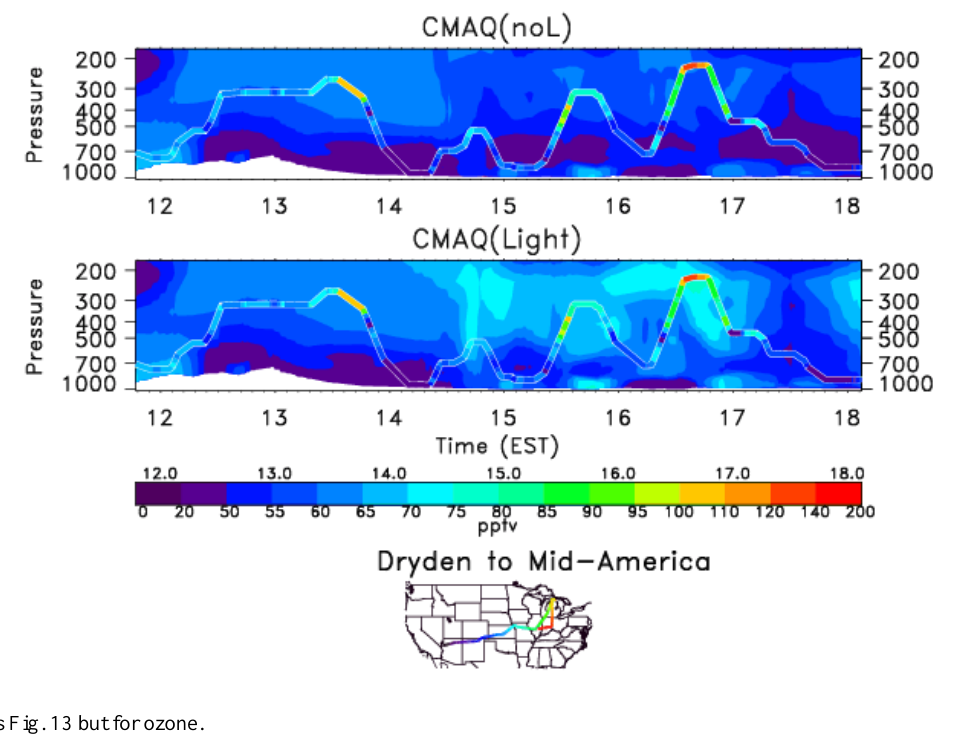
Figure 14. Same as Fig. 13 but for ozone. Fig. 14. Same as Fig. 13 but for